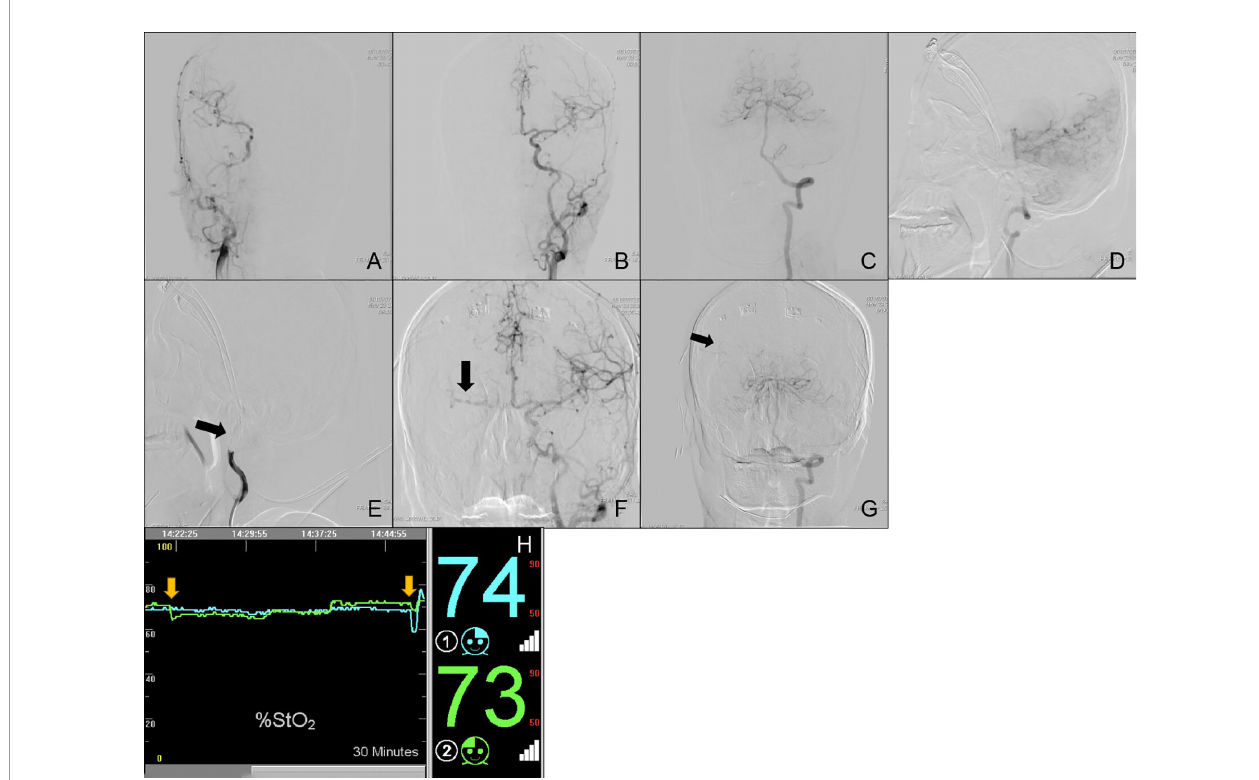
FIGURE 3 | Cerebral angiography and cerebral rSO 2 monitoring of Case Nos. 76 and 80. (A – G) Multi-side view of cerebral angiography. (H) Real-time rSO 2 monitoring. The blue line represented rSO 2 on the left cerebral hemisphere, the green line represented rSO 2 on the right cerebral hemisphere, the yellow arrow indicates a sudden drop in rSO 2